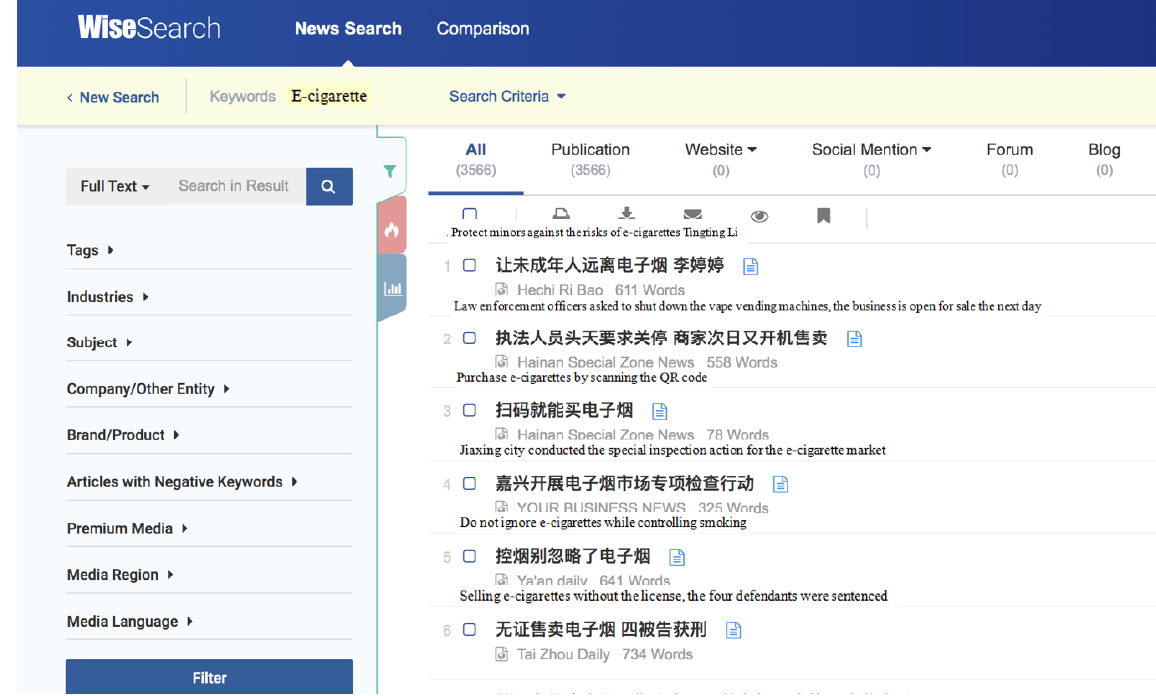
Figure 1. The screenshot of Huike database search page.